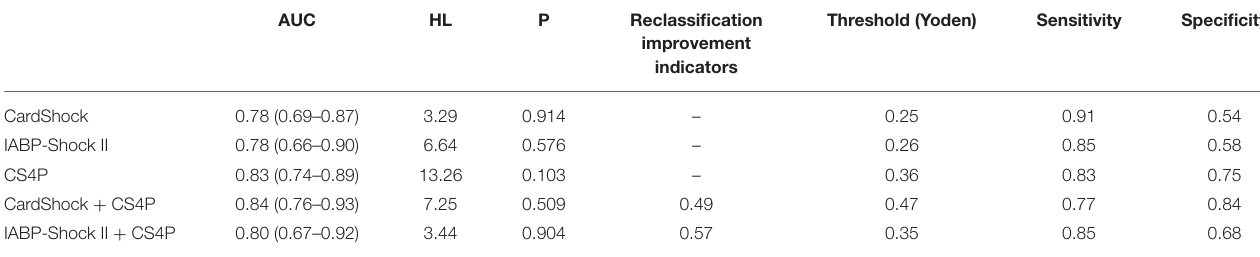
TABLE 6 | Comparison of CS4P, CardShock, and IABP-Shock II scores (46).